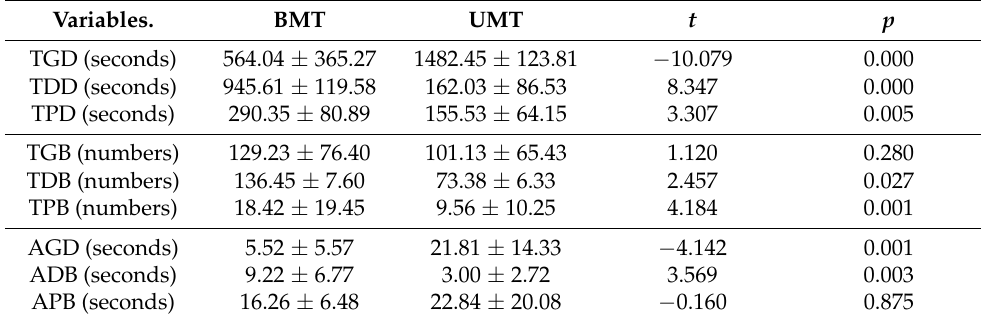
Table 2. Results of Behavioral Analysis of the Participants. Variables.